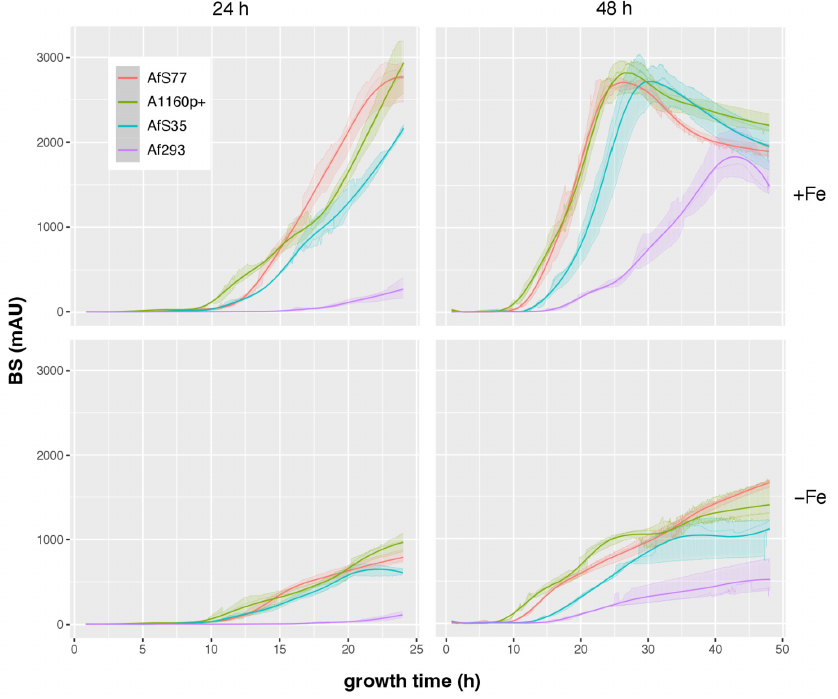
Figure 10. CGQ-mediated growth monitoring of A. fumigatus AfS77 compared to A1160p+, AfS35, 10 and Af293 cultured for 24 h and 48 h under +Fe and − Fe conditions. Details of the graph are as in the caption of Figure